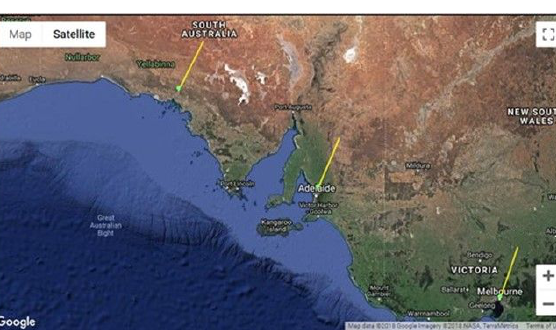
Figure 16: GPS antennas of South Australia from JPL. Image modi- fied after